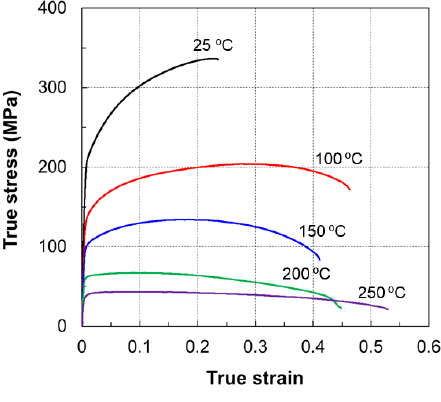
Figure 5. Stress-strain curves in uniaxial tension test at different temperatures.